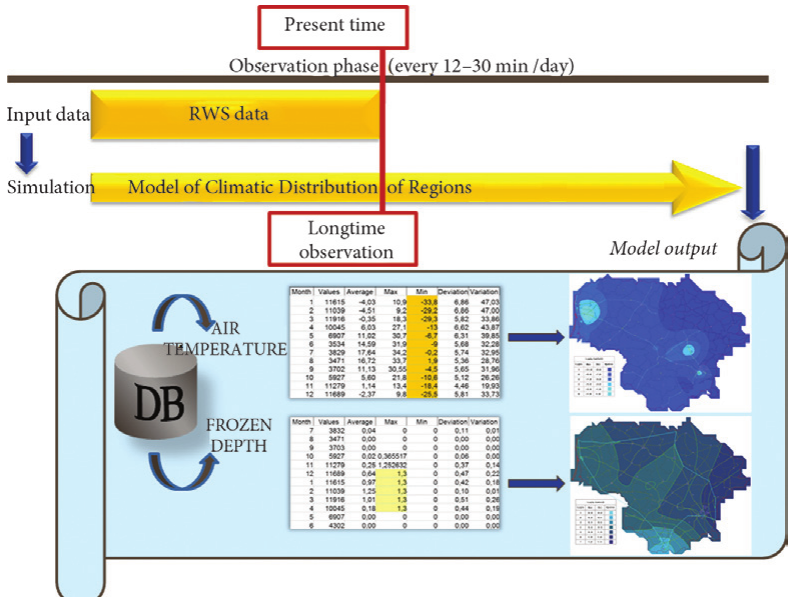
Fig. 4. Model of climatic distribution of regions